Question: Draft a figure caption describing what is shown.
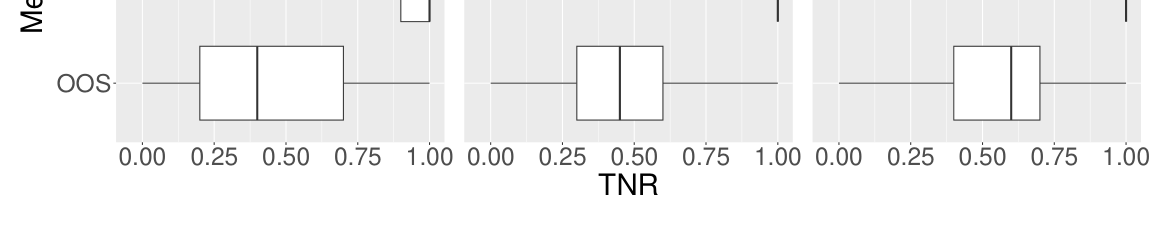
Answer: Simulation 2: boxplots for TNR (the true negative rate for the input variables) for the models selected by each objective function.